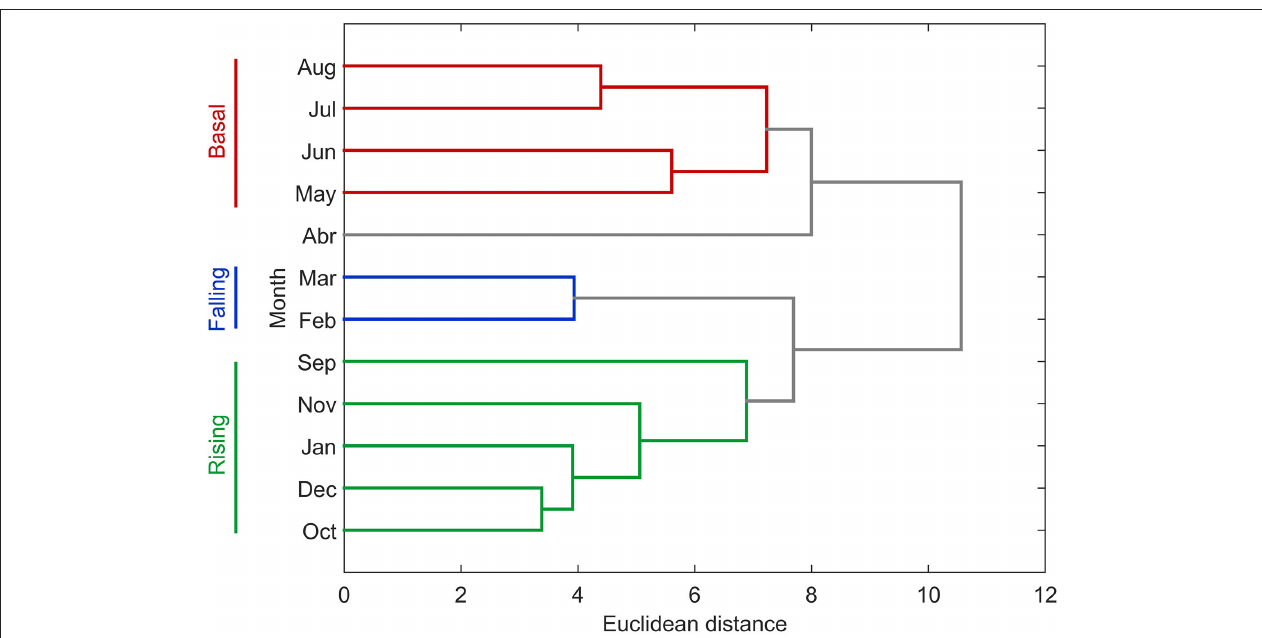
FIGURE 6 | Dendrogram presenting hierarchical clustering of the degree of similarity between monthly bio-oceanographic characteristics. We used monthly mean surface (0–10m) values for temperature, salinity, nutrients (nitrate, phosphate and silicate) along with monthly means for satellite and in situ net primary production, satellite and in situ photic layer depth, satellite Chlorophyll-a and upwelling index.